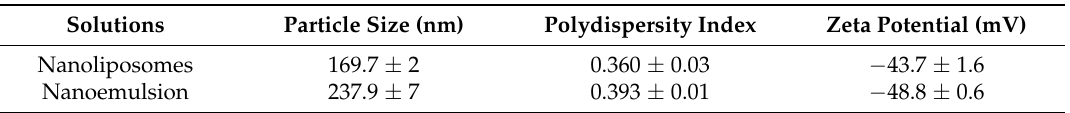
Table 1. Mean particle size (nm), polydispersity index (PDI), and zeta potential (mV) of the rapeseed nanoliposomes and nanodroplets of rapeseed oil emulsion.